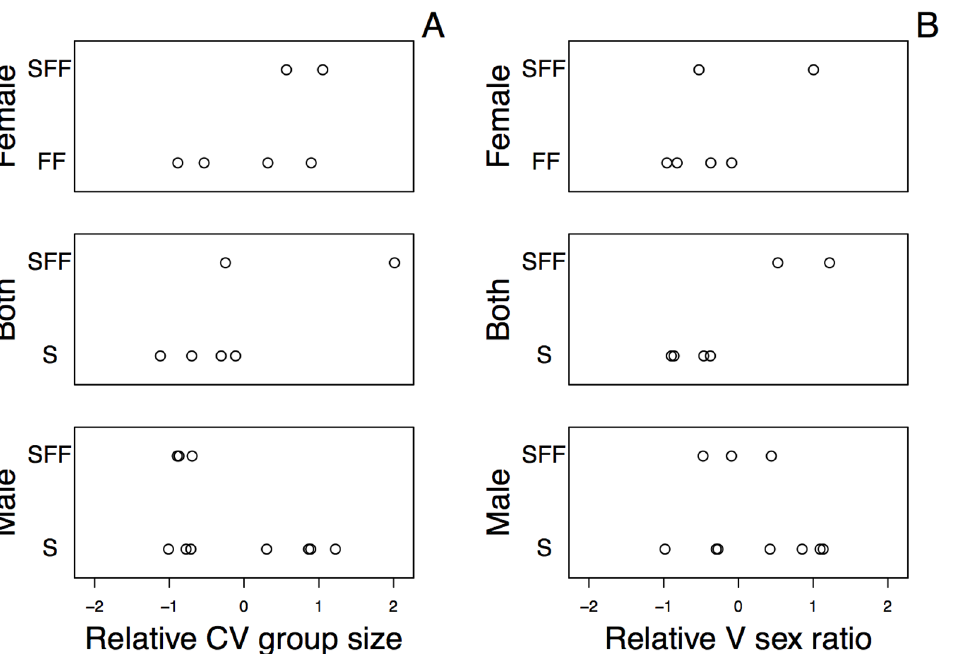
Figure 3. Grouping traits (S, FF, and SFF) for species divided by Dispersal regime (Male-biased, Female-biased, or Bi-sexual) versus (A) the relative CV in Group size and (B) the relative variance in sex ratio. For longitudinal studies, the relative CV in group sizes were calculated as the residuals of a regression of CV in group size against the log 10 maximum number of samples per group (Figure 2), where the intercepts were allowed to differ. Similarly, for cross-sectional studies the mean CV in group size was subtracted from the CVs from each study. The residuals for all three types of studies (longitudinal group, longitudinal population, and cross-sectional) were then standardized to have a variance of one. This standardization makes the variation in CVs in group size the same for all three types of study. The analysis of variance in sex ratio (after arcsine-square-root transformation) was performed similarly to make the variation within the three types of studies the